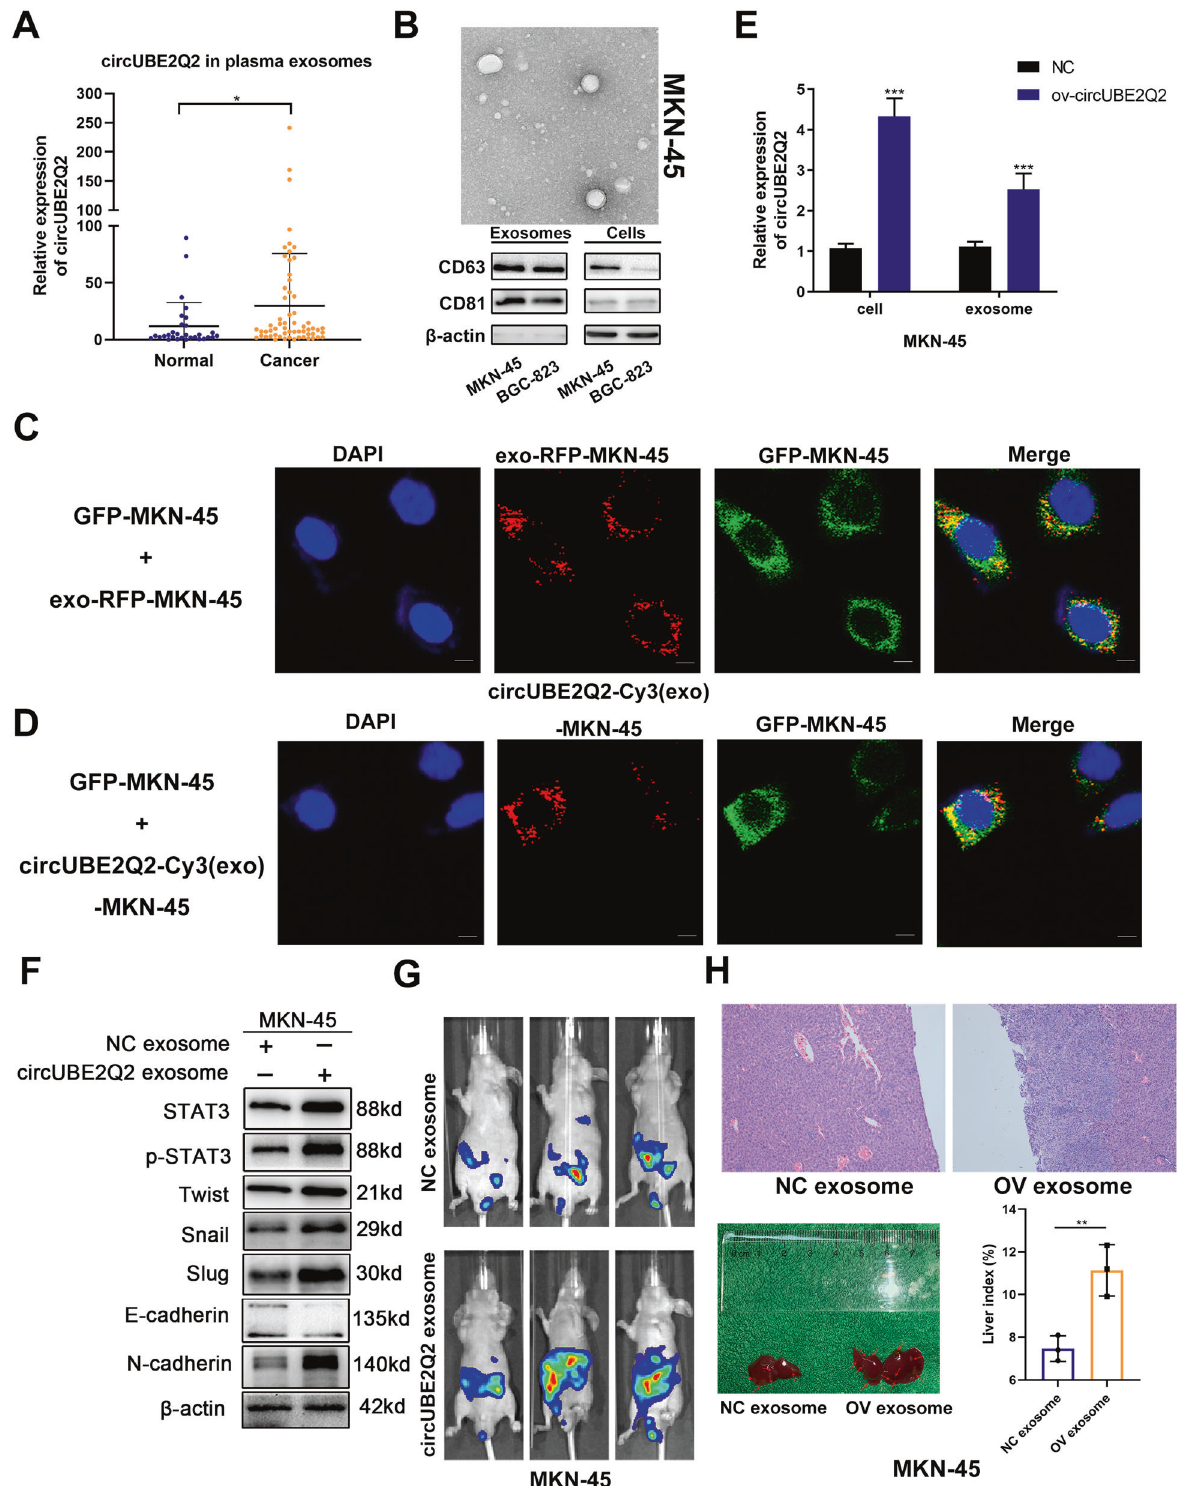
Fig. 7 Exosomal circUBE2Q2 regulates the STAT3 signaling pathway and EMT in vitro and promotes metastasis in vivo. A Expression level of circUBE2Q2 in the plasma exosomes from normal people ( n = 30) and GC patients ( n = 60) determined via qRT-PCR. B Existence and morphology of exosomes puri fi ed from MKN-45 cell medium (exosome-free FBS) determined by a transmission electron microscope (TEM) and exosomal markers CD63 and CD81 via western blottings. C The existence of the red exosome signals in the cytoplasm of MKN-45 cells, scale bar = 20 μ m. D The red signals of circUBE2Q2 in the cytoplasm of GFP-labeled MKN-45 cells, scale bar = 20 μ m. E Higher circUBE2Q2 expression in exosomes puri fi ed from cirUBE2Q2-overexpressing MKN-45 cells detected by qRT-PCR. F Protein levels of STAT3, p-STAT3, Twist, Snail, Slug, N-Cadherin, and E-Cadherin detected by western blottings. G Peritoneal metastasis in MKN-45 cells treated with NC or circUBE2Q2 OV exosomes measured by luciferase intensities. H The cancerous node size characterized by the liver tissues for H&E staining. Liver index = liver weight/body weight. Data are expressed as the mean ± SD. * p < 0.05, ** p < 0.01, *** p < 0.001. Cell Death and Disease (2021)